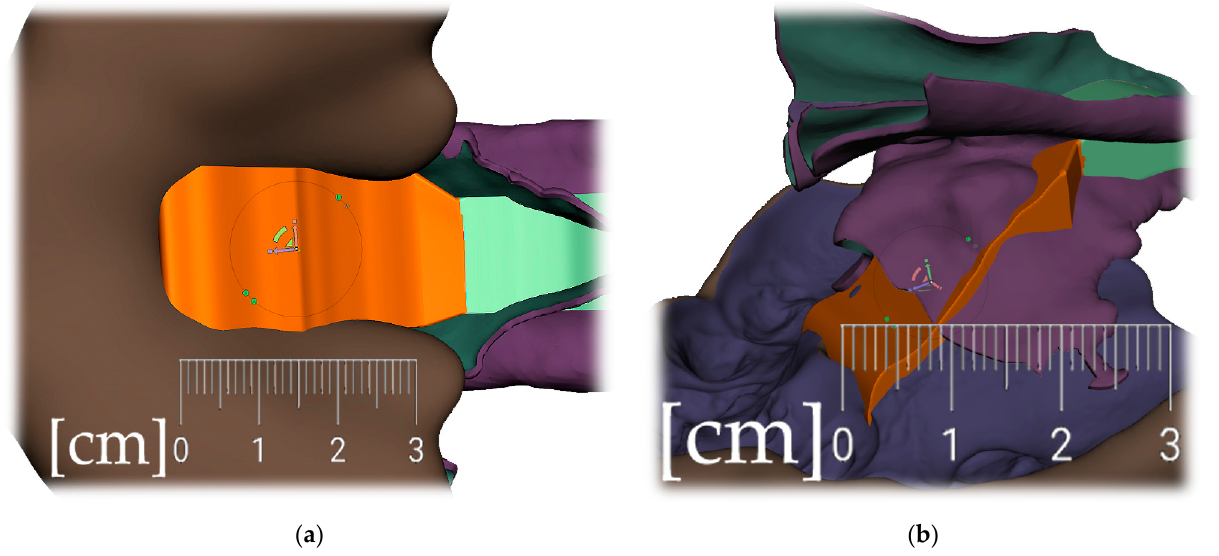
Figure 14. Connecting the body and the spur: ( a ) utilization of Select -> Deform -> Transform tool keystroke “T” to extend the palatal end of the spur to desired width and length; ( b ) transform tool will allow change of axis orientation of the selected part. The remaining mesh differences shall be manually changed via Sculpt -> Brushes -> Robust Brush and final merge of both parts by means of Boolean union after selection of both objects—the Spur part and the Alveolar part of the appliance.